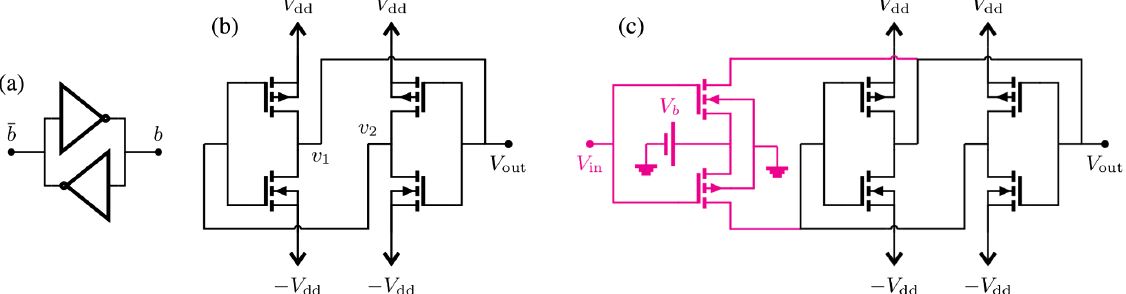
FIG. 13. (a) A bistable circuit constructed with two NOT gates, representing a bit. (b) Its CMOS implementation. (c) Complete design of a p -bit. The bistable circuit constituting the bit is shown in black and is the same as in (b). The biasing circuit is shown in